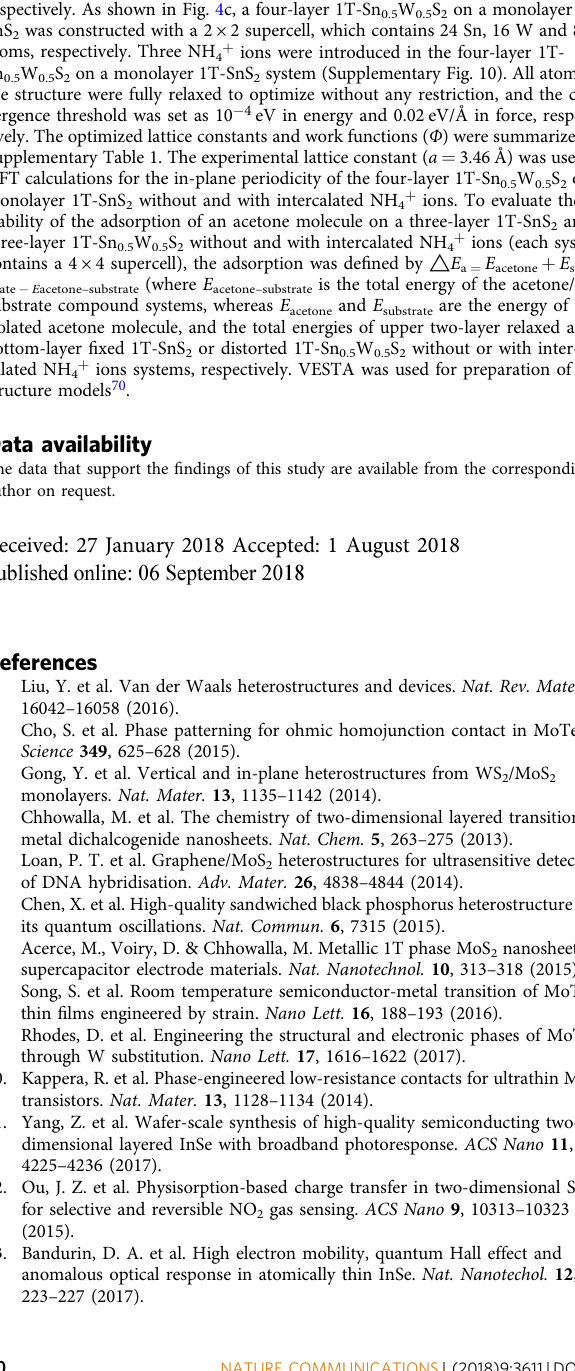
vergence threshold was set as 10 − 4 eV in energy and 0.02eV/Å in force, respec- tively. The optimized lattice constants and work functions ( Φ ) were summarized in Supplementary Table 1. The experimental lattice constant ( a = 3.46Å) was used in DFT calculations for the in-plane periodicity of the four-layer 1T-Sn 0.5 W 0.5 S 2 on a monolayer 1T-SnS 2 without and with intercalated NH 4 + ions. To evaluate the stability of the adsorption of an acetone molecule on a three-layer 1T-SnS 2 and three-layer 1T-Sn 0.5 W 0.5 S 2 without and with intercalated NH 4 + ions (each system contains a 4 ×4 supercell), the adsorption was de fi ned by △ E a = E acetone + E sub- strate − E acetone – substrate (where E acetone – substrate is the total energy of the acetone/ substrate compound systems, whereas E acetone and E substrate are the energy of the isolated acetone molecule, and the total energies of upper two-layer relaxed and bottom-layer fi xed 1T-SnS 2 or distorted 1T-Sn 0.5 W 0.5 S 2 without or with inter- calated NH 4 + ions systems, respectively. VESTA was used for preparation of the structure models 70